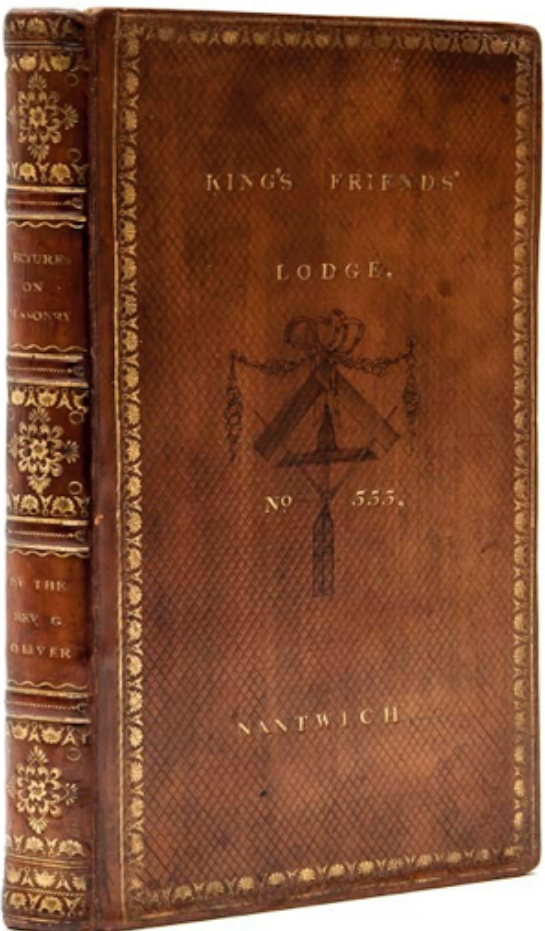
Fig. 8. George Oliver, Signs and Symbols Illustrated and Explained, in a Course of Twelve Lectures on Freemasonry (Grimsby, 1826). Unidentified 19th-century workshop. With thanks to Dreweatts Bloomsbury